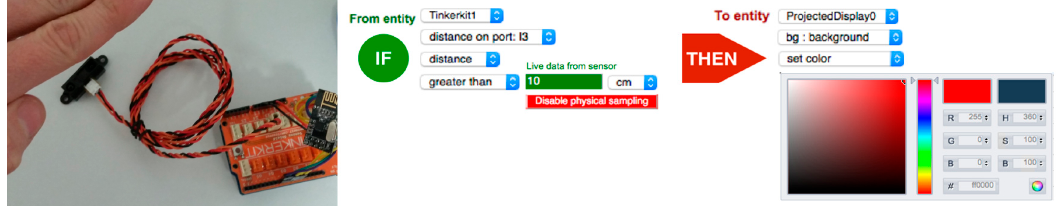
Figure 7. Programming-by-demonstration. The user interacts with the sensor to complete trigger- action rules with live sensor data.